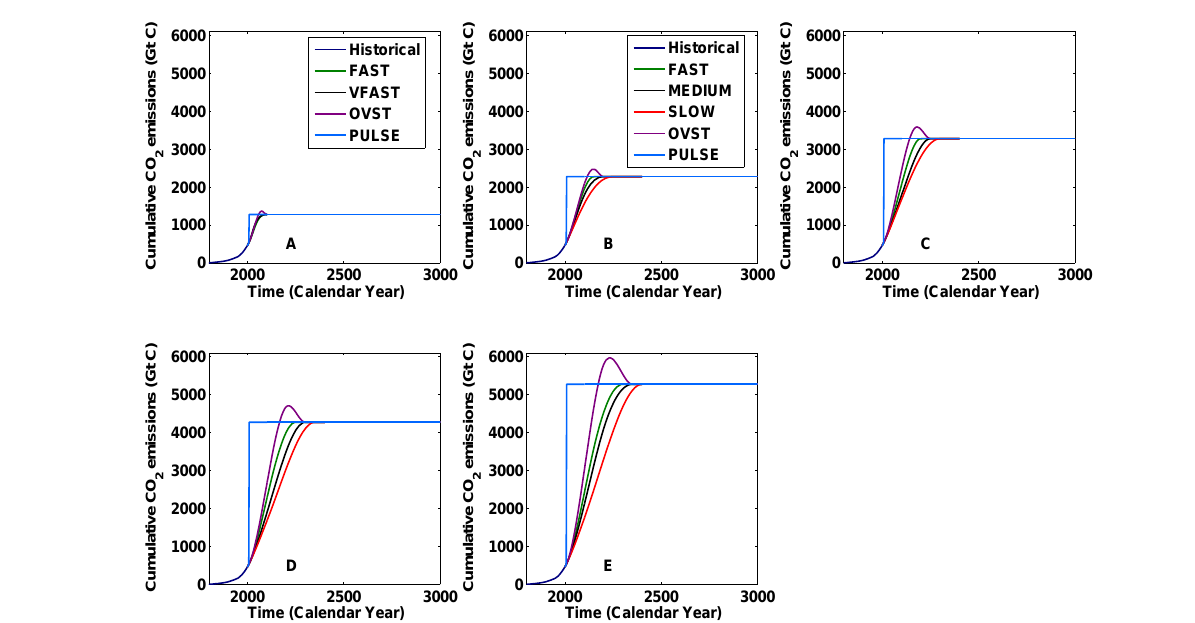
Figure 1. Global cumulative CO 2 emissions (fossil fuel plus LUC emissions) for the 1275–5275GtC cumulative emission scenarios. (a) 1275GtC scenarios, (b) 2275GtC scenarios, (c) 3275GtC scenarios, (d) 4275GtC scenarios, and (e) 5275GtC scenarios. Note: legend for (b) also applies to (c–e) .